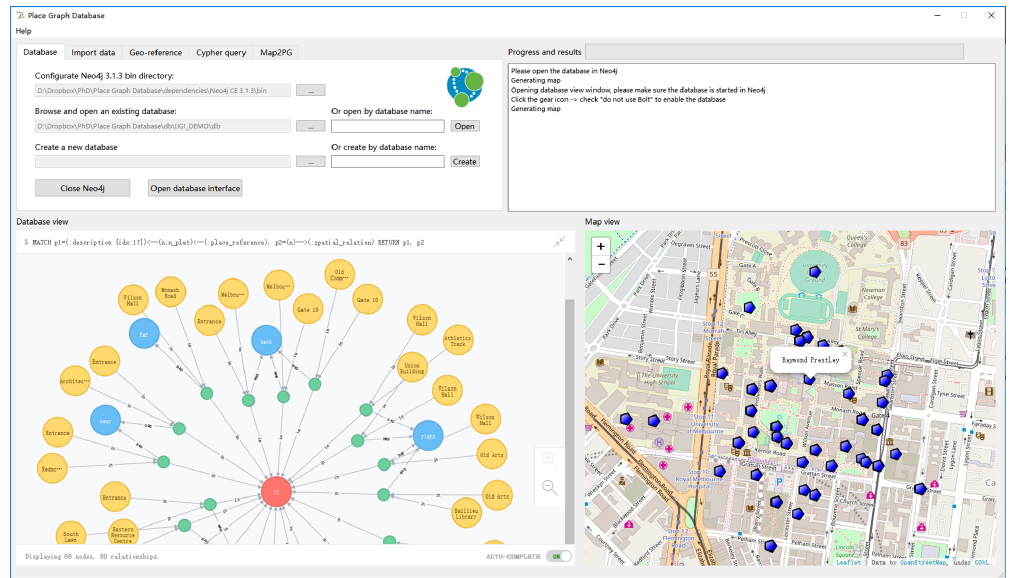
Figure 6. The implemented extended place graph database management system interface, with an example visualization of part of the test extended place graph. A clearer example of an extended place graph as well as explanations is provided in the Appendix A.